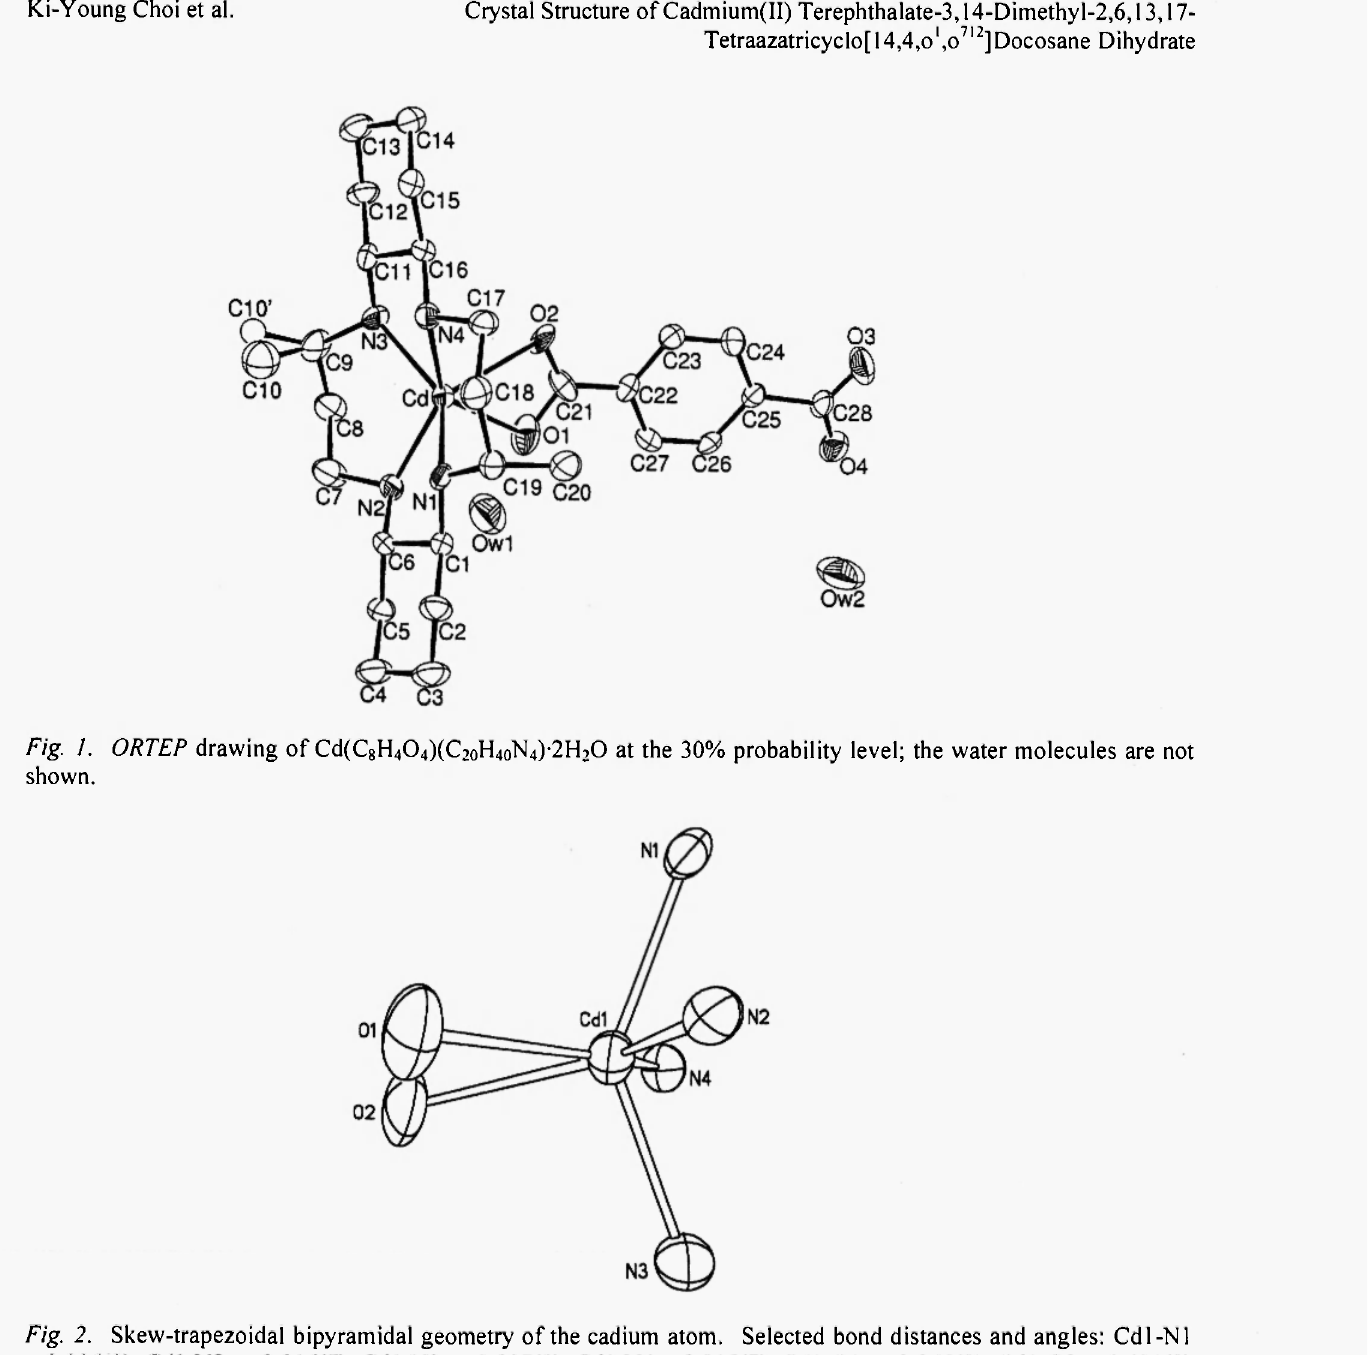
Fig. 2. Skew-trapezoidal bipyramidal geometry of the cadium atom. Selected bond distances and angles: Cdl-Nl = 2.306(8), Cdl-N2 = 2.316(7), Cdl-N3 = 2.307(8), Cdl-N4 = 2.315(7), Cdl-01 = 2.365(8), Cdl-02 = 2.431(8) Ä; Nl-Cdl-N2 = 76.2(3), Nl-Cdl-N3 = 138.0(3), Ν1 -Cd 1-N4 = 83.2(3), Nl-Cdl-Ol = 104.0(3), Ν1 -Cd 1-02